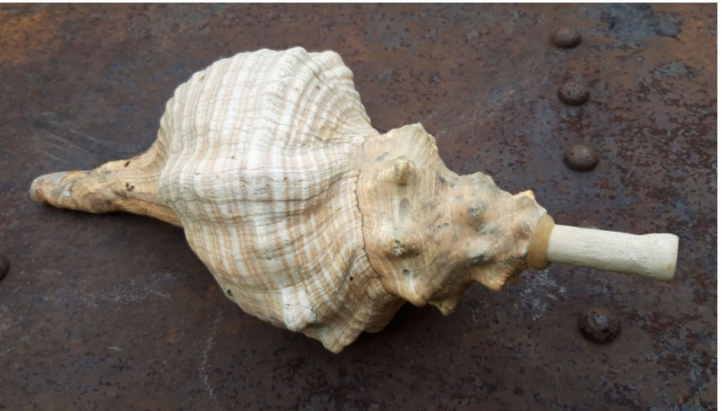
Figure 8. Shell horn made from Triplofusus princeps . Experimental model equipped with a ceramic cup-shaped